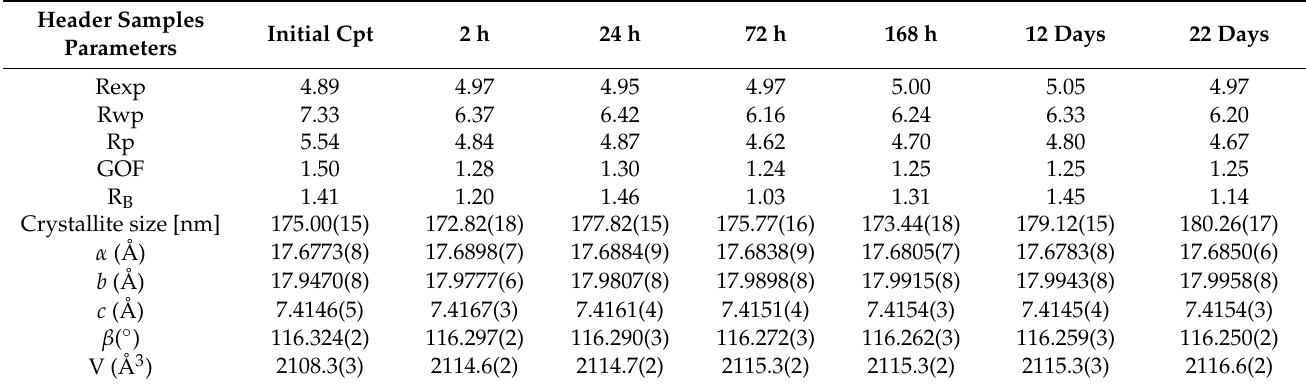
Table 3. Reliability factors, crystallite size, and unit cell parameters of initial and Cd-clinoptilolite from the ion exchange sequence at 90 °C.